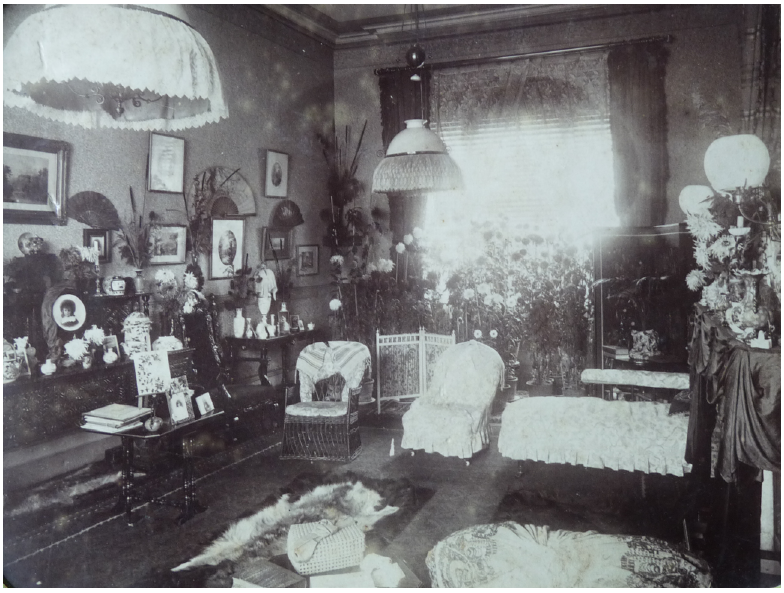
Figure 1: A late-Victorian parlour from Stratford-upon-Avon, Warwickshire (Author’s collection) The sin of bad taste has been assigned to the nouveaux riche for many centuries but the strength of moral censure was heightened in the Victorian era because movement up the social hierarchy was so